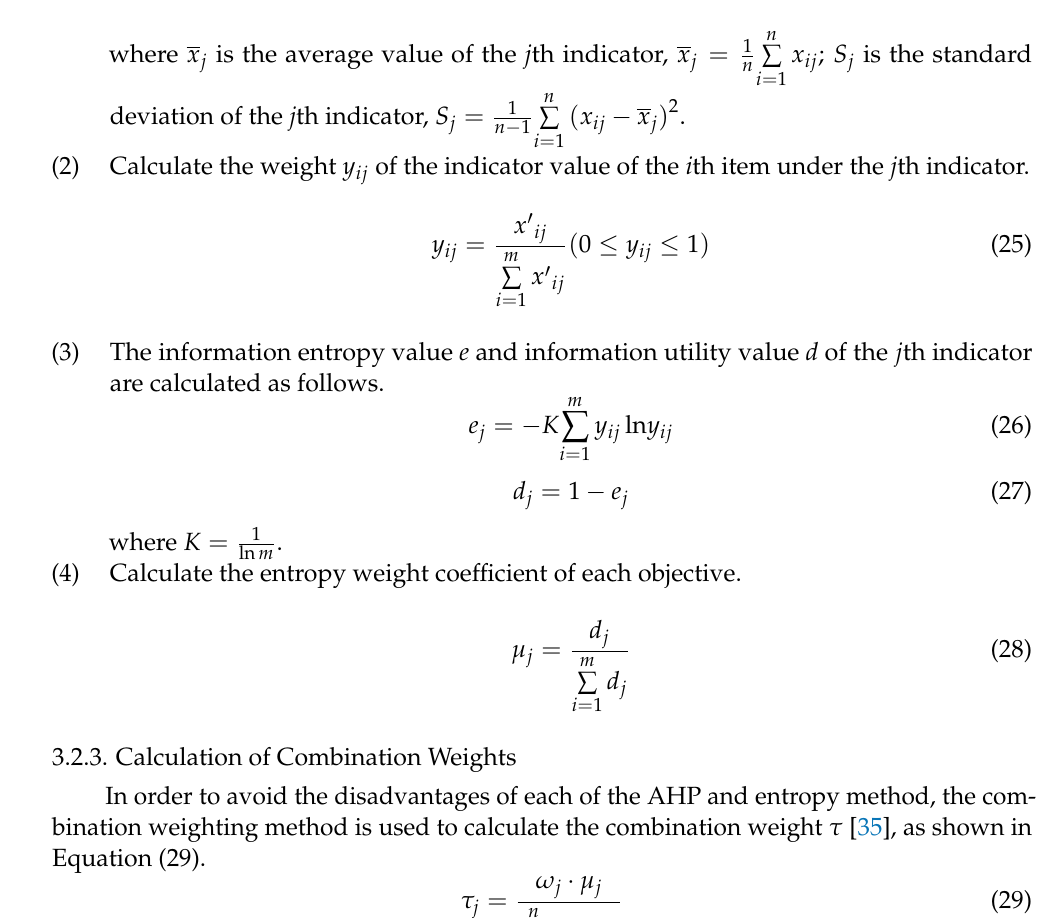
14 4.1. Feature Selection for the Painting Objects The selection of the painting process equipment and the determination of the process parameters are directly influenced by various factors. These include the basic attributes of the object to be painted, such as material, area, descaling grade, surface roughness, etc., as